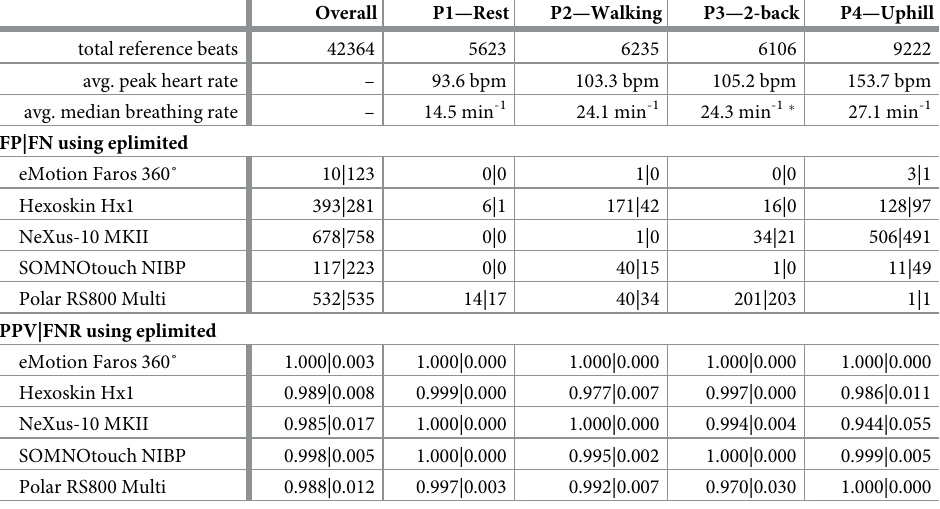
Table 4. QRS detection performance expressed by false positive (FP) and false negative (FN) counts and positive predictive values (PPV) and false negative rates (FNR) from bandpass-filtered (3–20 Hz) ECGs (heartbeats anno- tated by